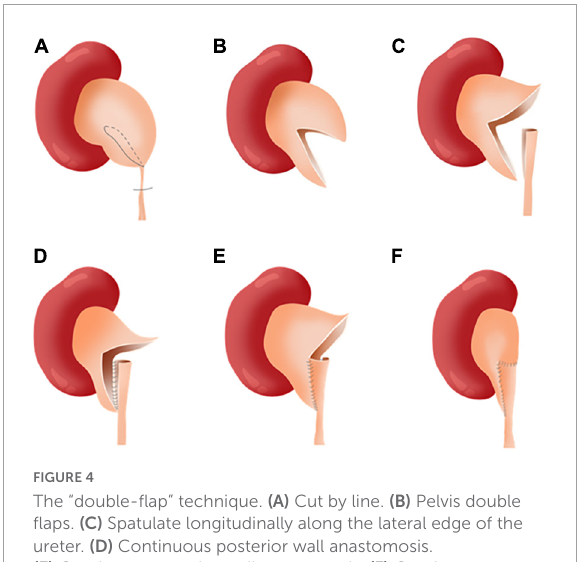
TABLE 2 Perioperative outcomes.